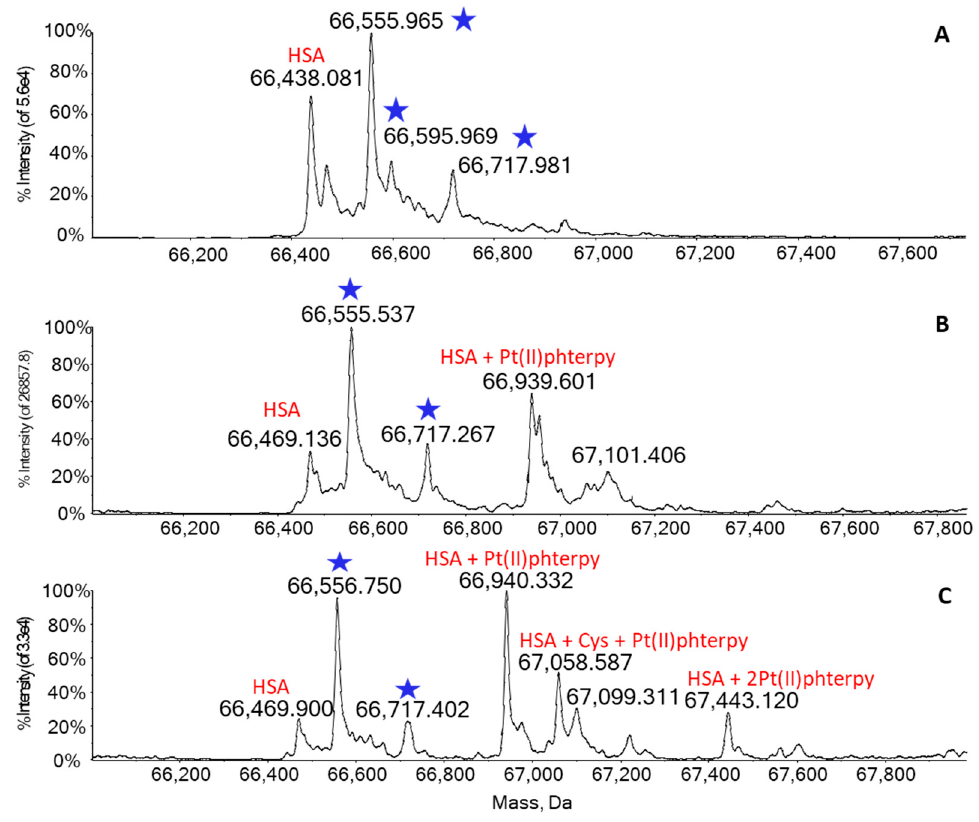
Figure 4. Deconvoluted ESI mass spectra of 2 (1 × 10 − 4 M) and 1 (5.5 × 10 − 5 M) incubated with HSA (1.4 eq per platinum) at room temperature for 24 h in ammonium acetate solution (2 × 10 − 3 M, pH = 6.8). Panel ( A )—complex 1 in the dark; panel ( B )—complex 1 irradiated for 5 min at 365 nm (UV lamp); panel ( C )—complex 2 . Blue stars indicate post-translational modification of HSA.